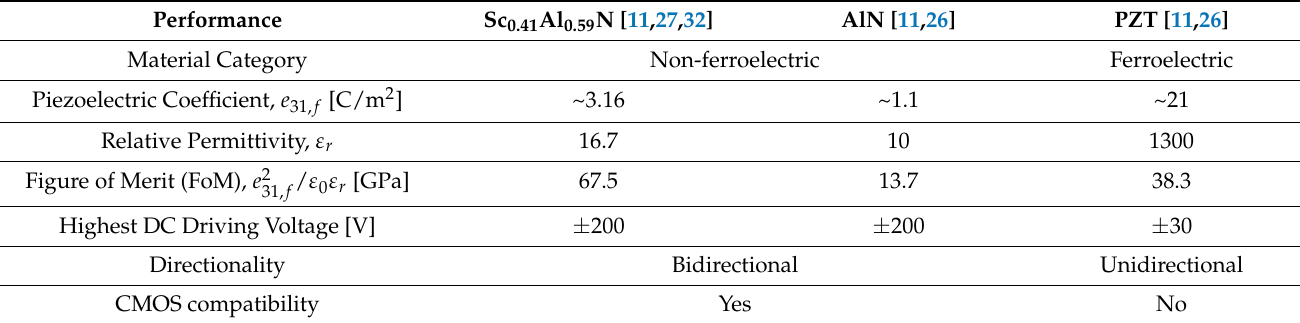
Table 1. Comparison between ScAlN, AlN and PbZr x Ti 1 − x O 3 (PZT) piezoelectric